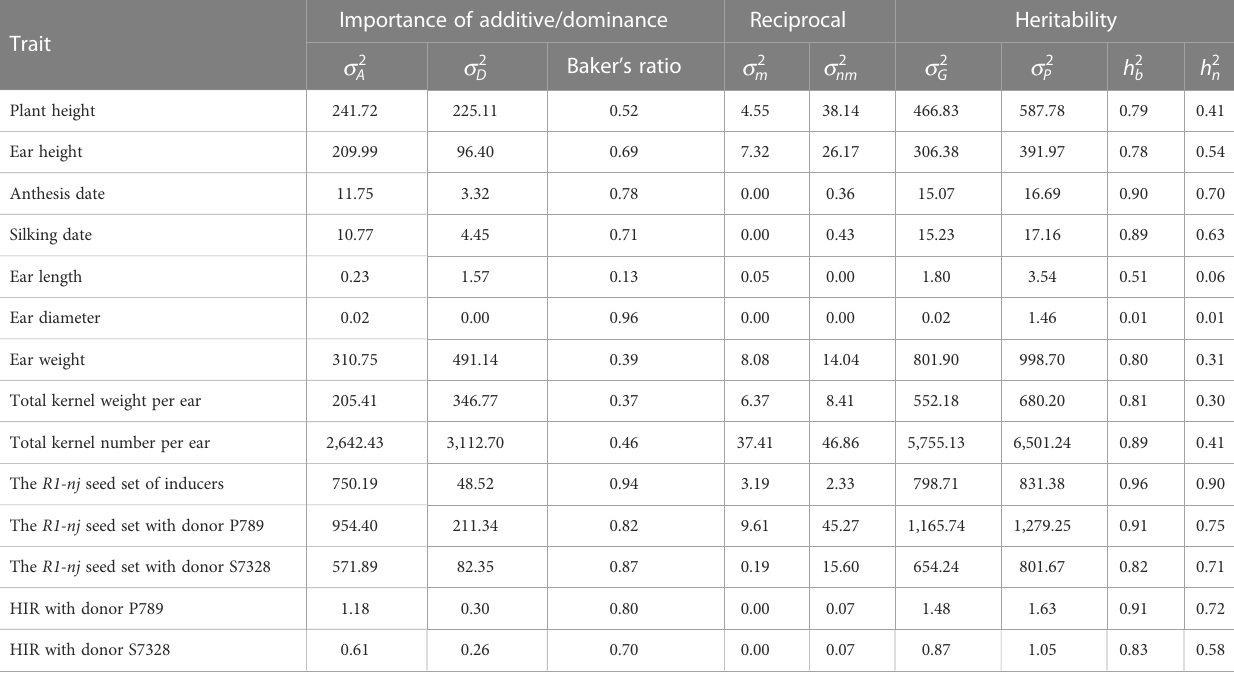
TABLE 3 Variance components and heritability estimates for agronomic traits, R1-nj seed set, and haploid induction rate of 8 parental genotypes and 56 F 1 progenies evaluated in the rainy season of 2021 and the dry season of 2021/2022.